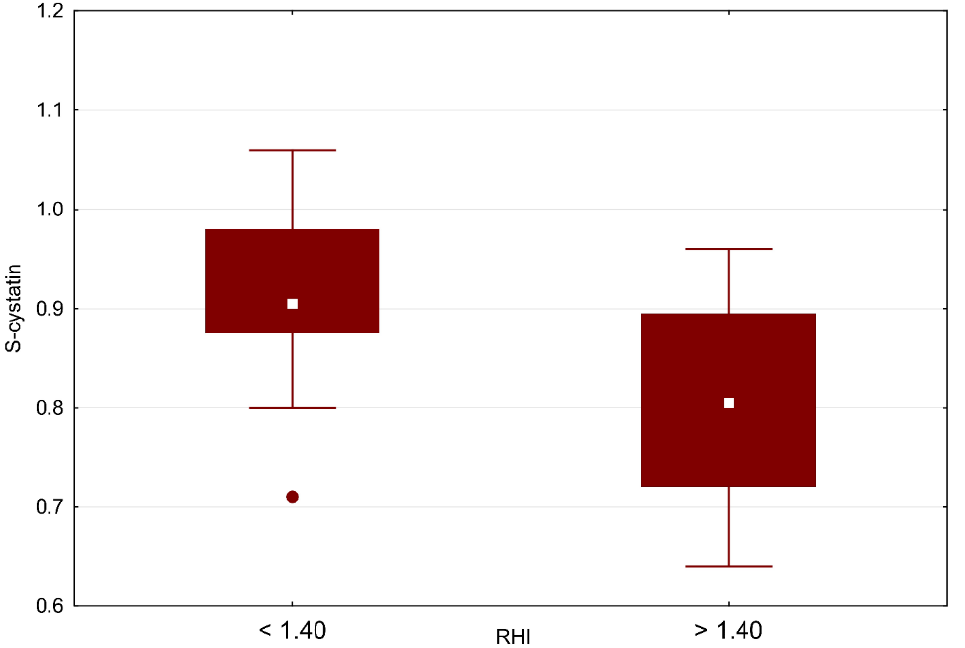
Figure 3. S-cystatin C vs. RHI cutoff for children with MIS-C. Boxes indicate the interquartile range. White squares within boxes indicate medians. Whiskers extend to the highest or lowest values. RHI: reactive hyperemic index.